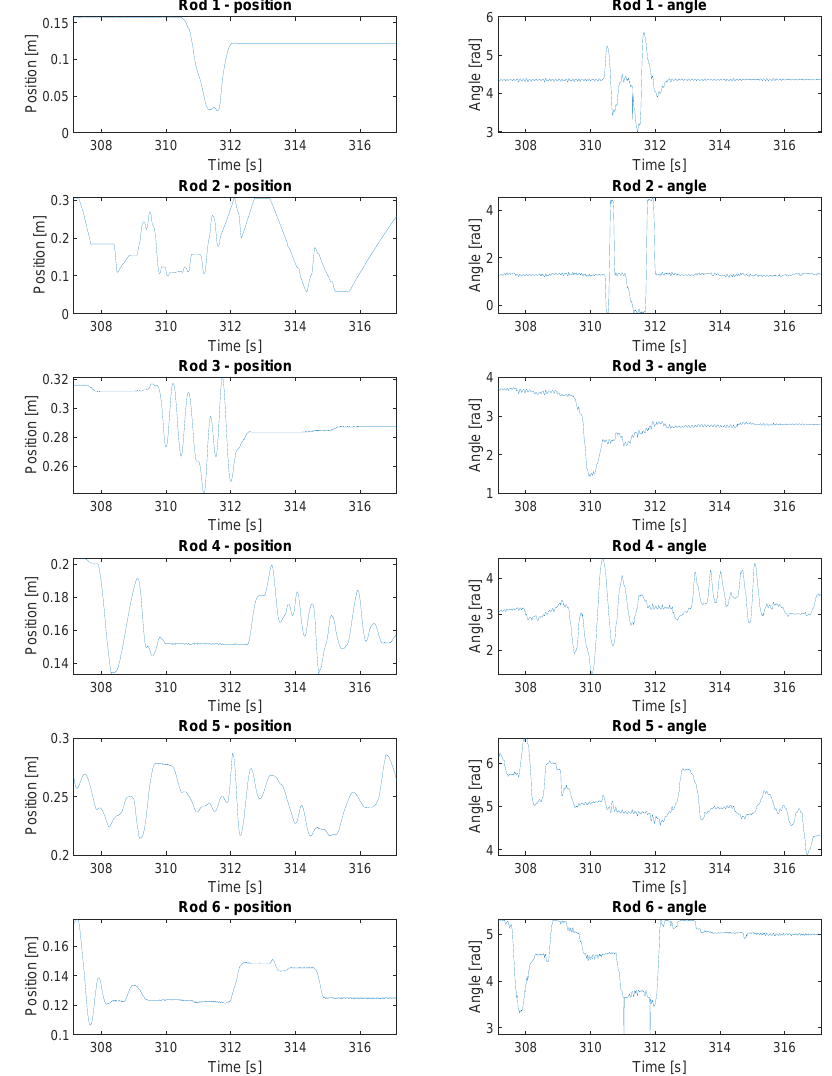
Figure 16. Tracking gameplay—rods positions and angles during a test